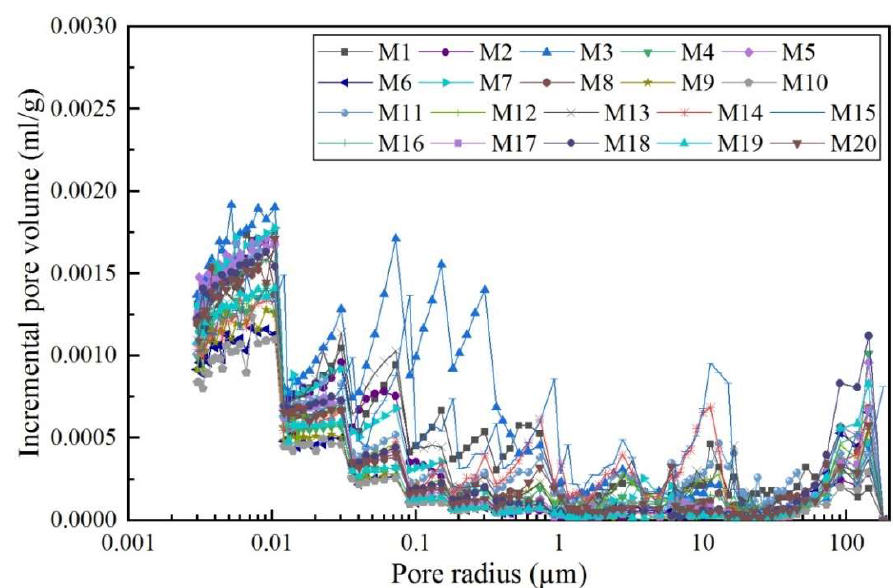
Figure 4. Incremental intrusion plots using HPMI data of high-rank coal samples.